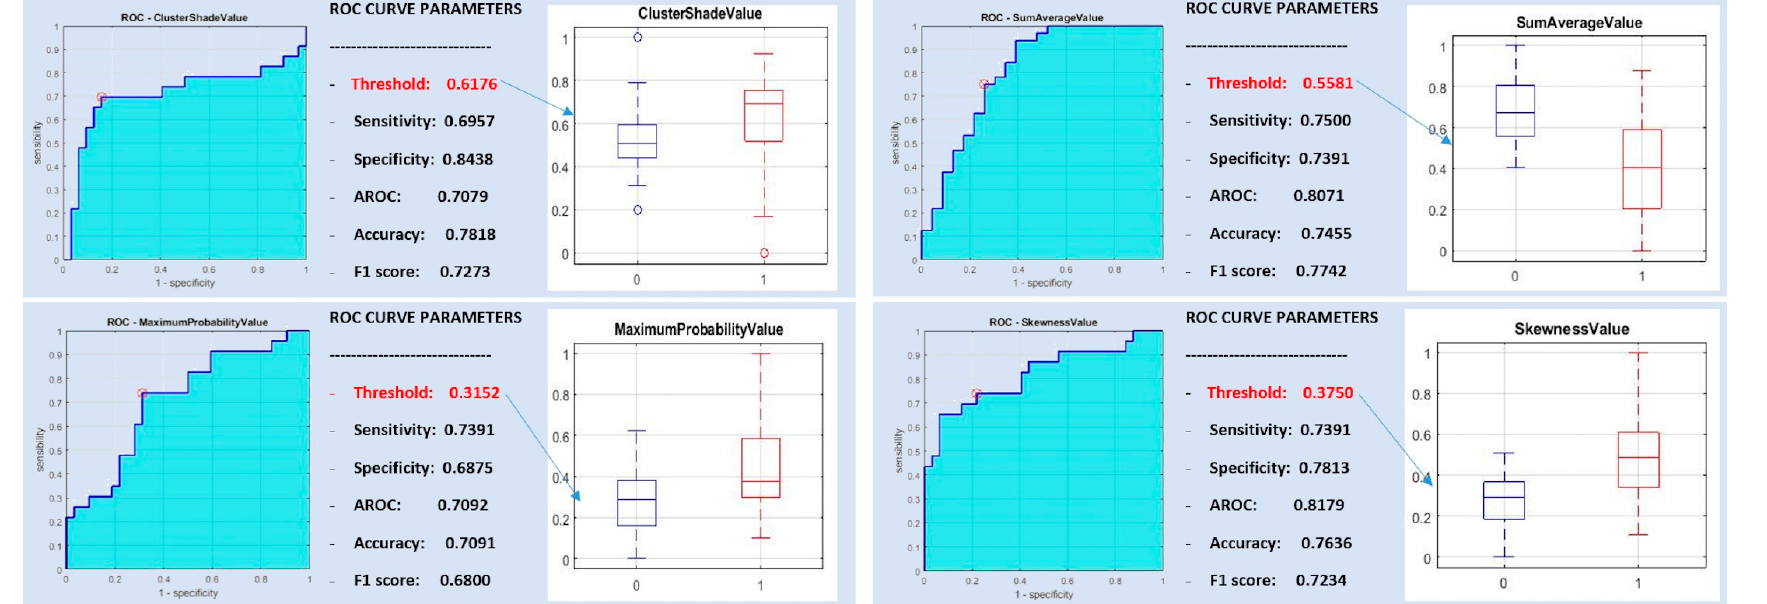
Figure 3. ROC curve analysis for pleomorphic adenoma versus Warthin tumors.